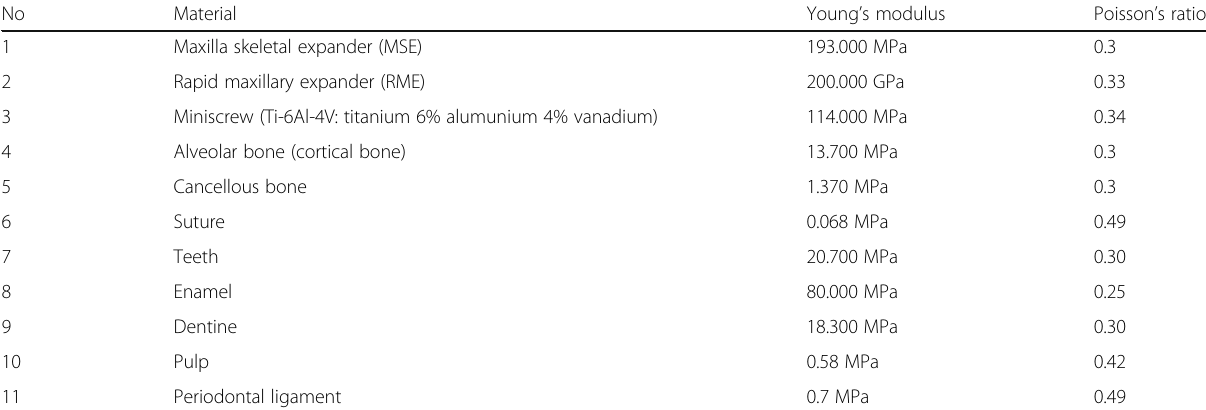
Table 1 Young ’ s modulus and Poisson ’ s ratio of various materials used in this study